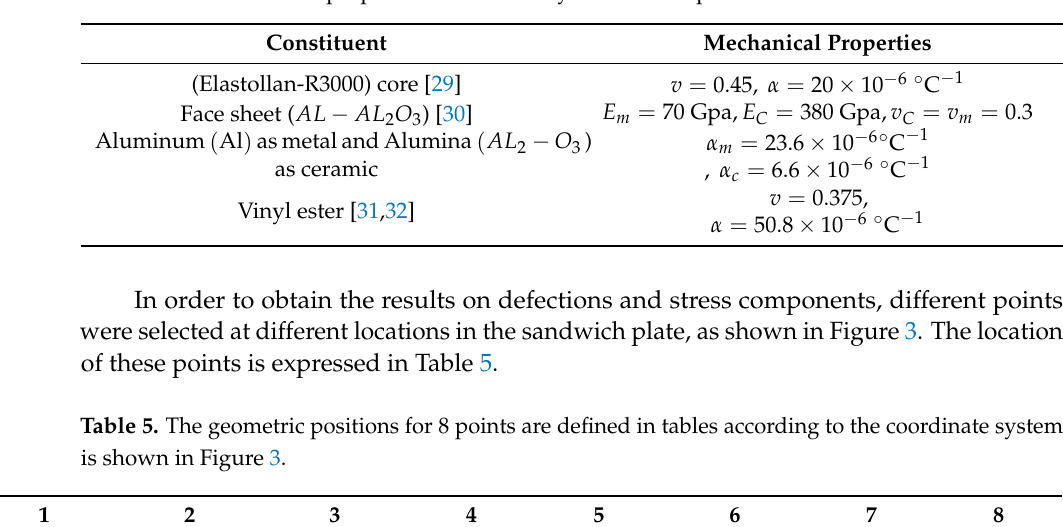
Table 4. The mechanical properties of the five-layer sandwich plate.